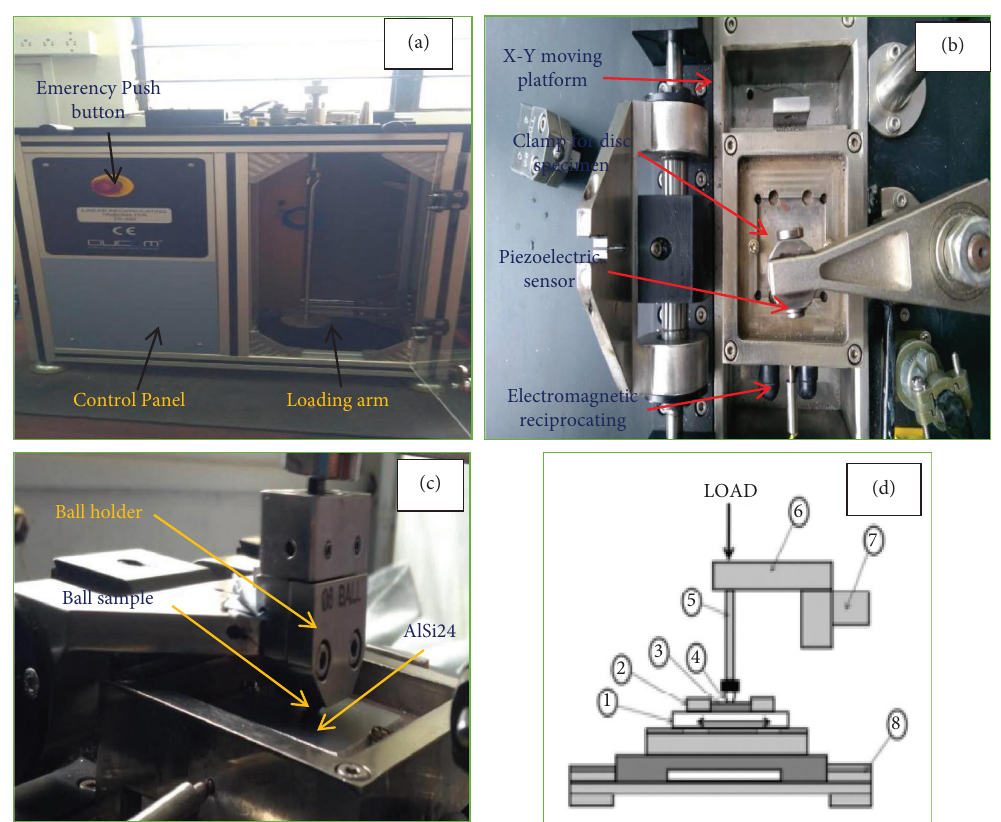
Figure 3: (a–c) Linear reciprocating tribometer test set up and (d) schematic of set up. (1) Electromagnetic reciprocating drive. (2) Clamp for disc specimen. (3) Disc sample. (4) Ball sample. (5) Ball holder. (6) Loading arm. (7) Piezoelectric sensor. (8) X - Y moving